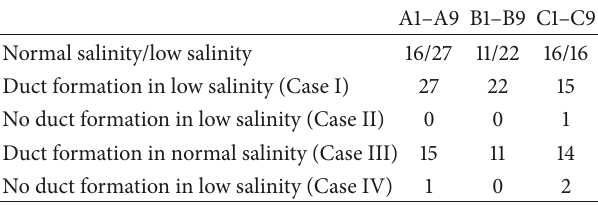
Table 1: Occurrence statistics of SSD formation and freshening process in the 8-year open